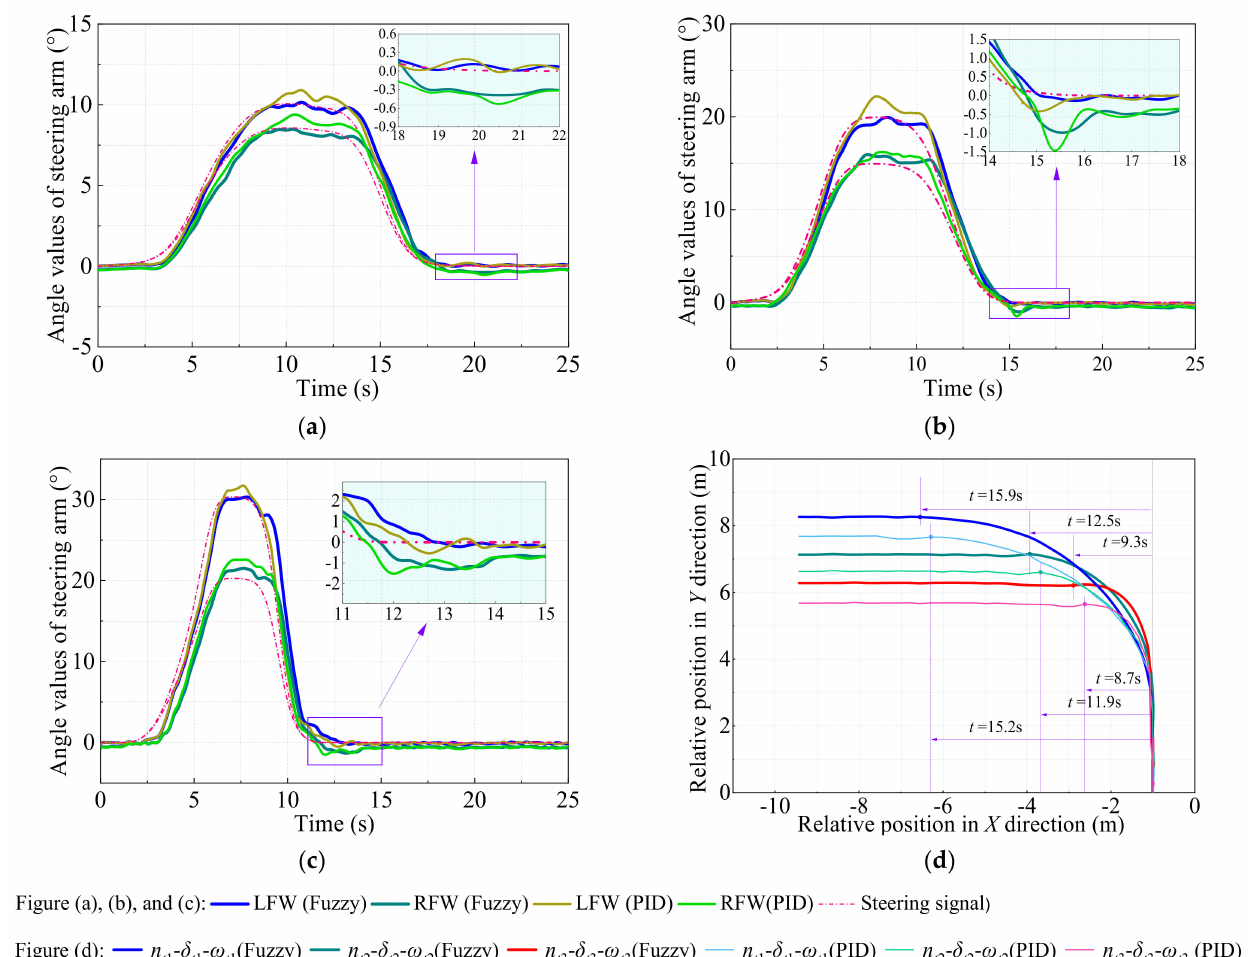
Figure 14. Angle changes and trajectories under different conditions: ( a ) condition n t 1 - δ t 1 - ω t 1 ; ( b ) condition n t 2 - δ t 2 - ω t 2 ; ( c ) condition n t 3 - δ t 3 - ω t 3 ; ( d ) centroid trajectories of the robot. Note: LFW denotes the left front wheel; RFW denotes the right front